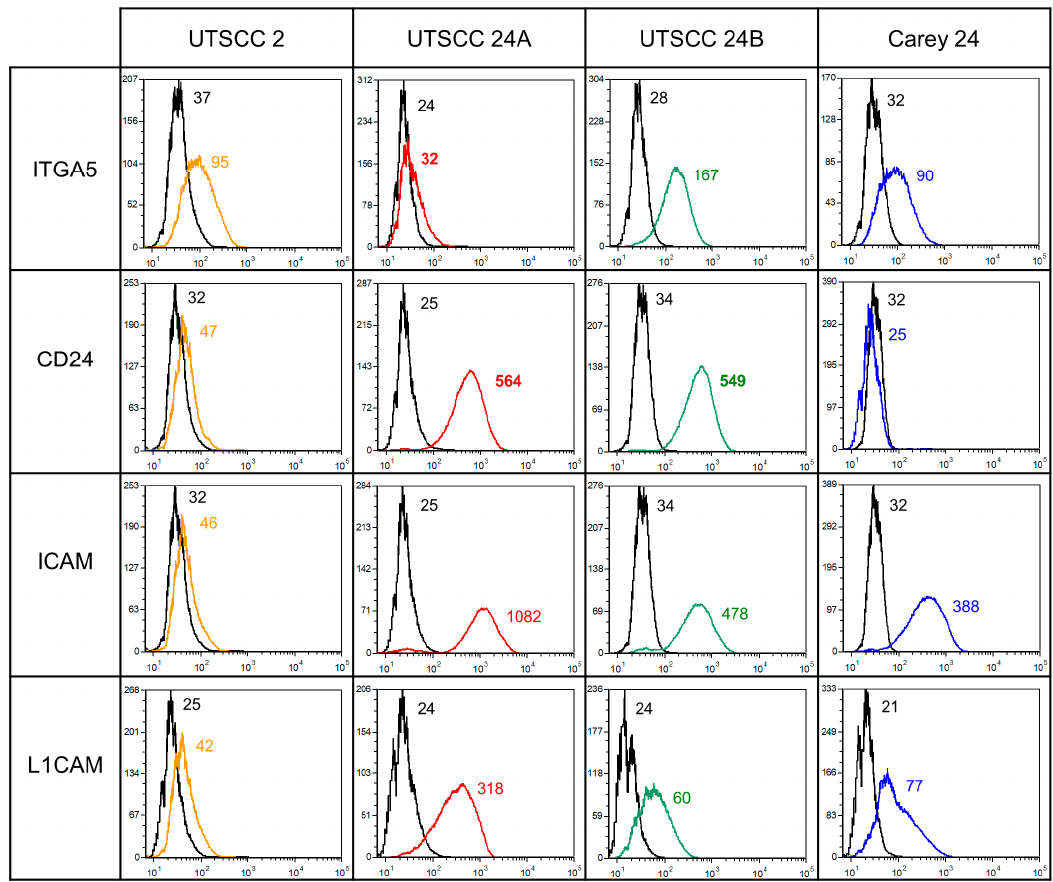
Figure 1. Representative flow cytometric histograms of selected cell surface glycoproteins, whose expression differed between the tested cell lines. Colored lines present specific mAb binding and black lines indicate the corresponding isotype control. Numbers show the mean fluorescence intensity (MFI). ICAM and L1CAM were highly expressed by UTSCC 24A and 24B and Carey 24, but lowly expressed by UTSCC 2. ITGA5 expression was the highest in UTSCC 24B, followed by UTSCC 2 and Carey 24, and was the lowest in UTSCC 24A. CD24 was detected on UTSCC 24A and 24B, but hardly on UTSCC2 and Carey 24 cells.